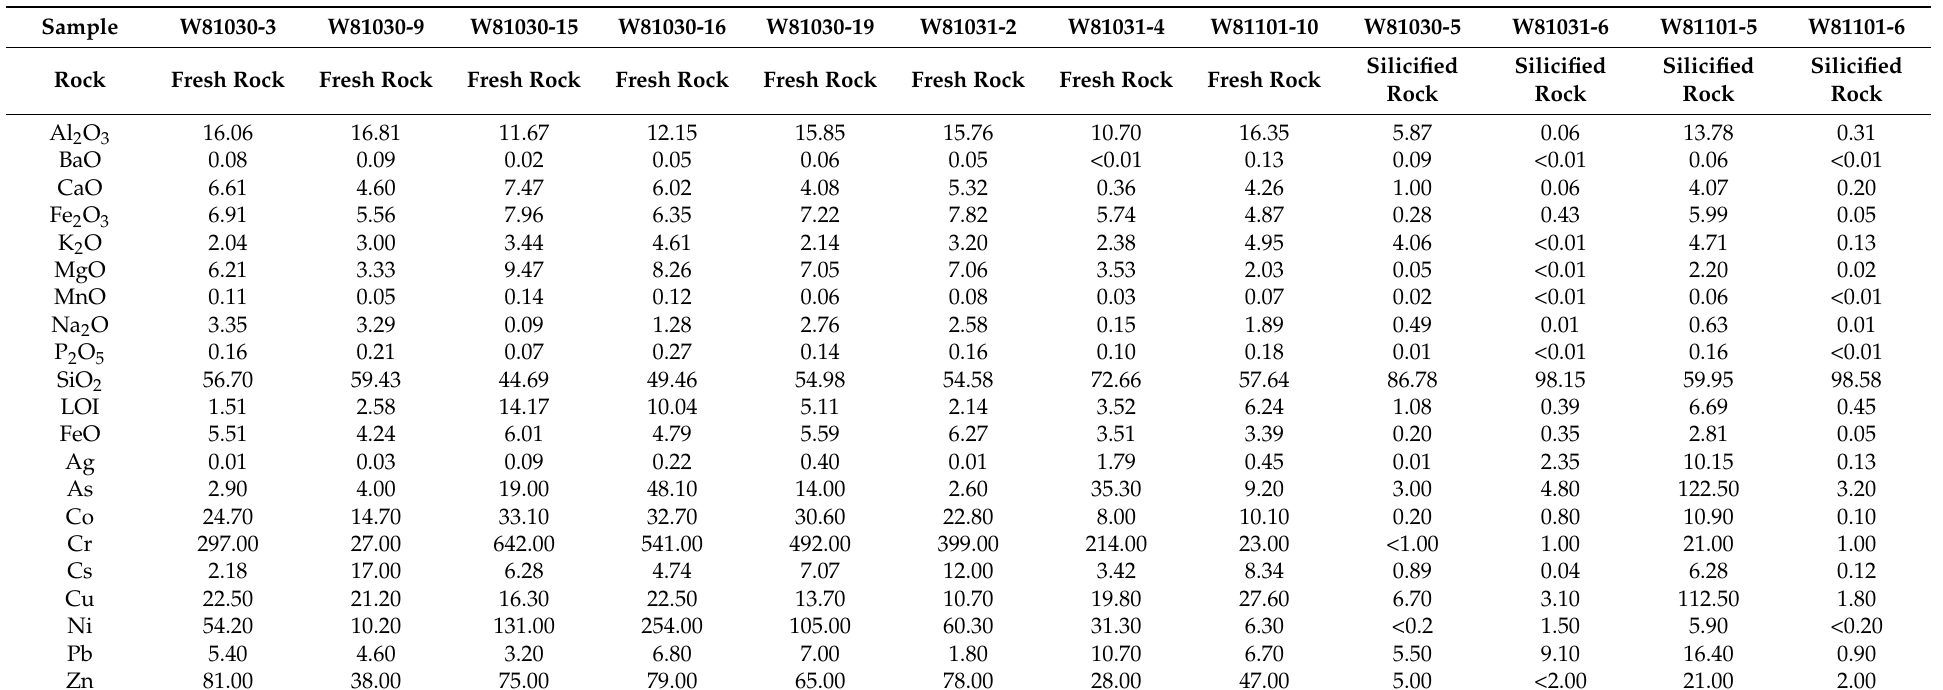
Table 1. Major and trace elements of the least altered and silicified microdiorite samples from the Wulong gold deposit.